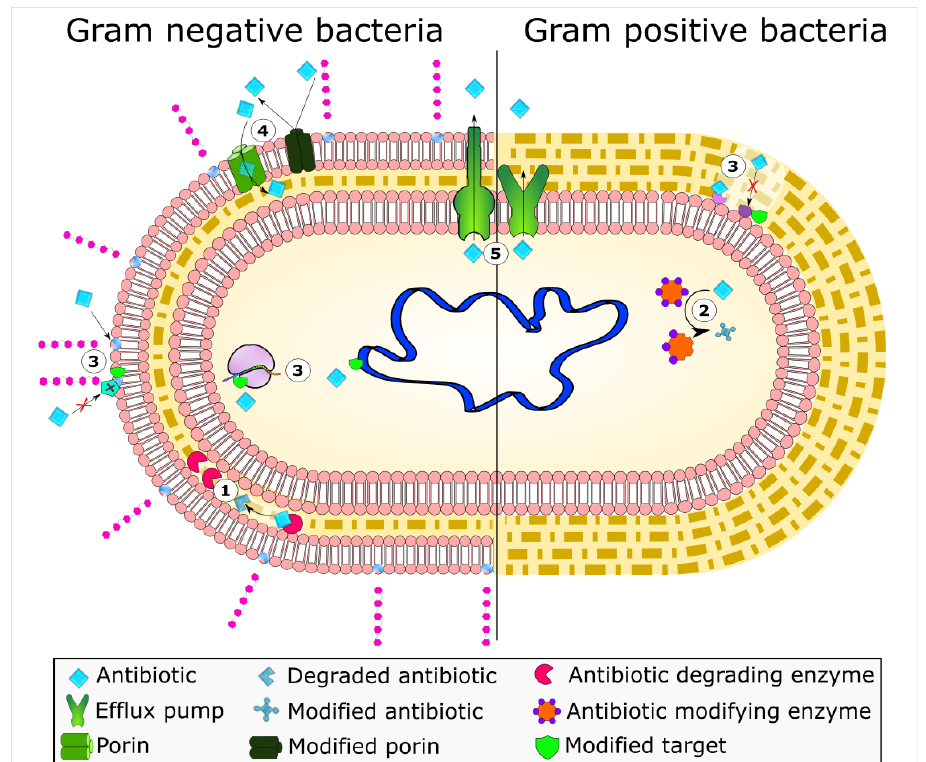
Figure 1. Bacterial mechanisms of resistance to antimicrobial agents. The common mechanisms of antibiotic resistance in bacteria are enzymatic hydrolysis ( 1 ), enzymatic modifications of antibiotics by group transfer and redox process ( 2 ), modifications of antibiotic targets ( 3 ), reduced permeability to antibiotics by modifications of porins ( 4 ), and active extrusion of antibiotics by membrane efflux pumps ( 5 ).